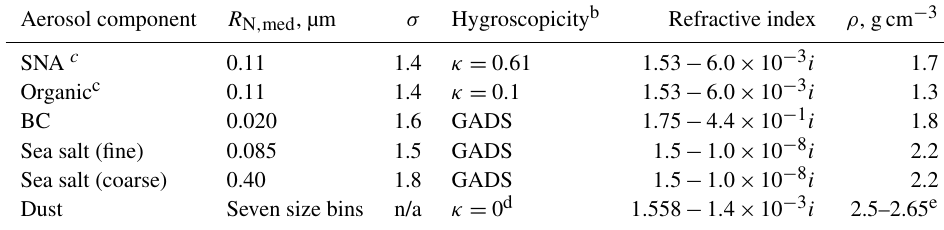
Table 3. Aerosol optical properties a . Note that n/a stands for not applicable. Aerosol component R N , med , µm σ Hygroscopicity b